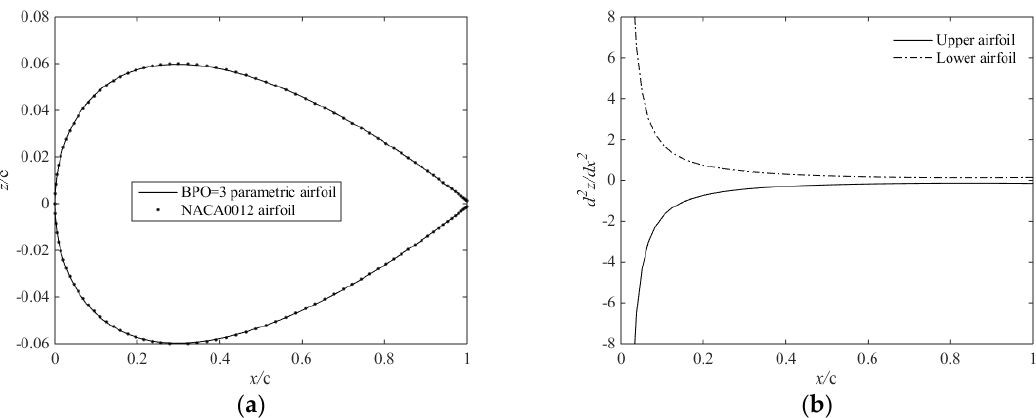
Figure 5. ( a ) Comparison between the CST parametric airfoil and the NACA0012 airfoil ( b ) NACA0012 airfoil second derivatives when BPO = 3.